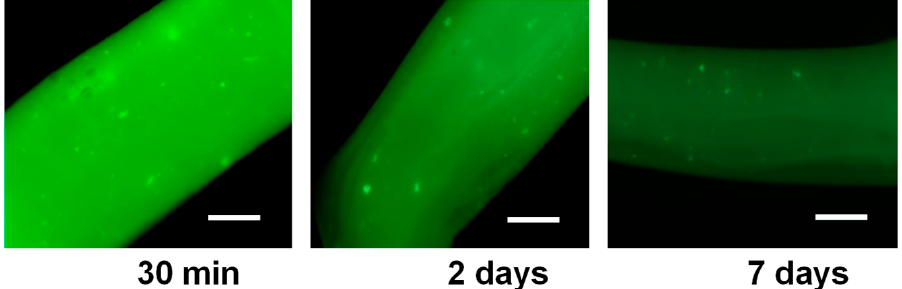
Figure 5. Fluorescence photos of printed filaments of CHI/CNF/Entrapped-cellulase filaments containing the cellulase stained with fluorescein isothiocyanate (FITC), after different times of incubation at 37 °C in PBS (pH 7.4). Scale bars: 200 µm.